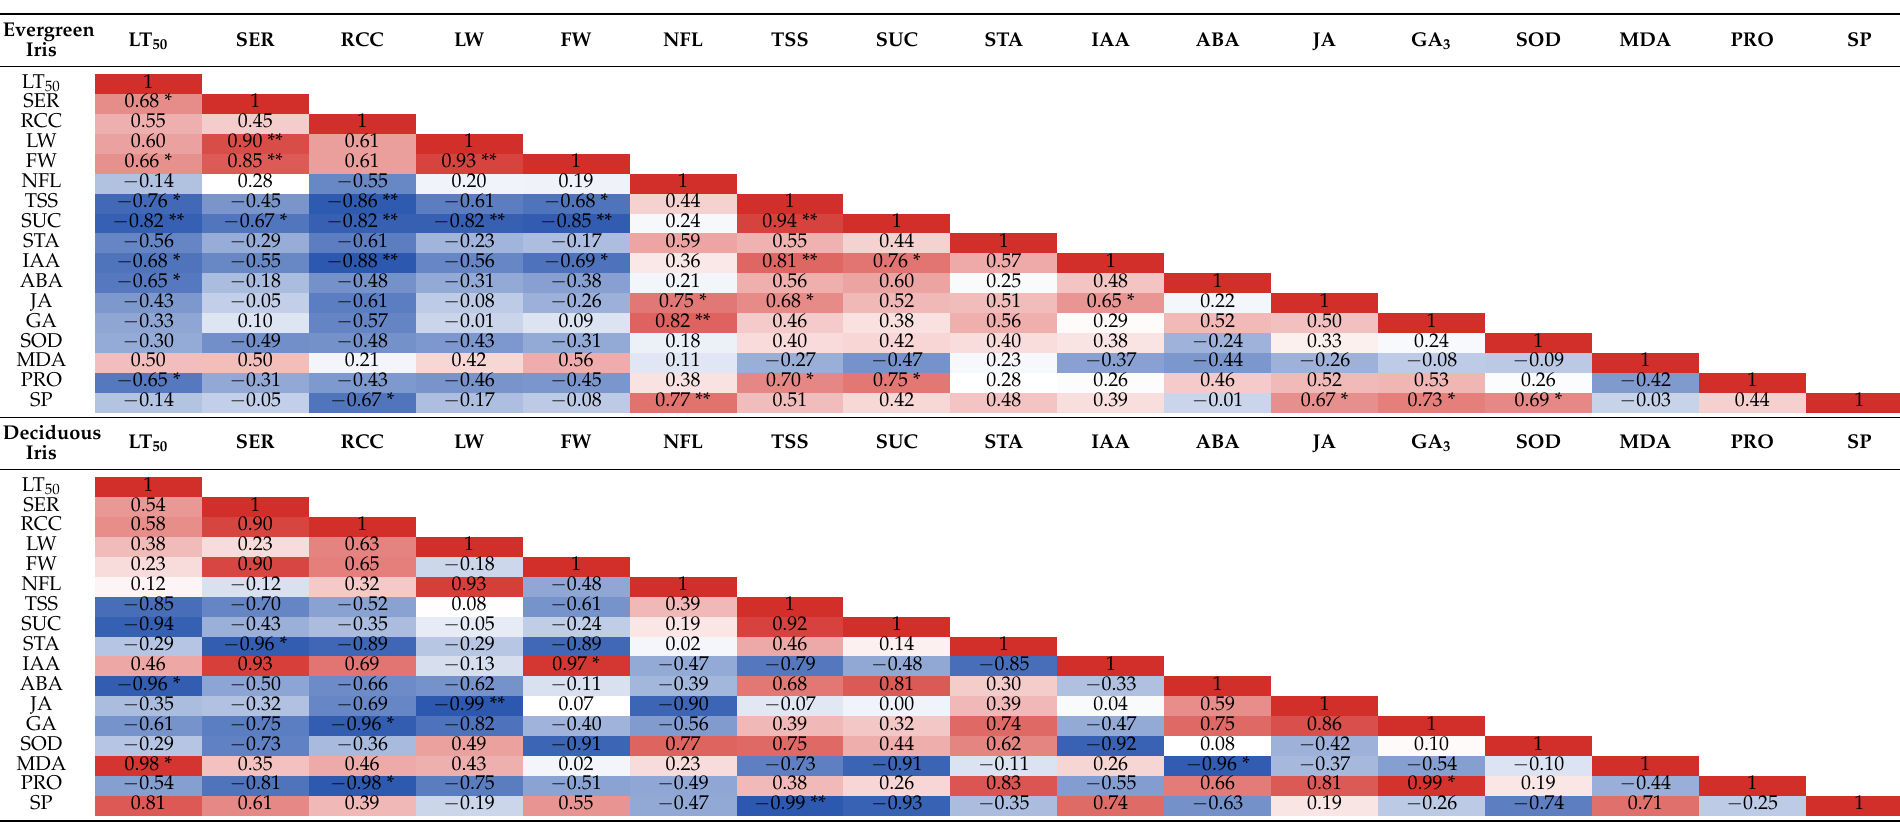
Table 1. Correlation analyses of semi-lethal temperature (LT 50 ) and morphological, physiological and biochemical indices in evergreen and deciduous irises during natural cold acclimation and